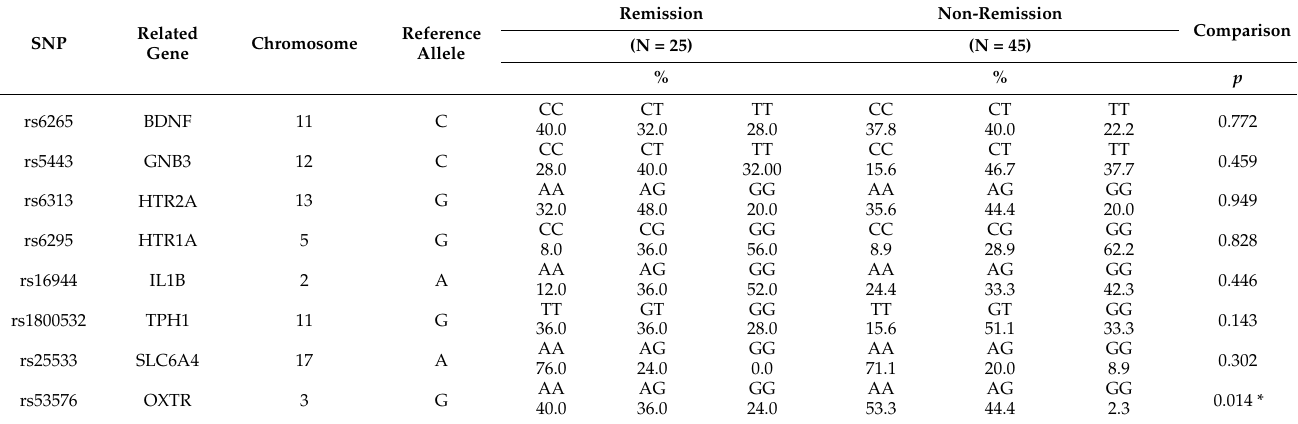
Table 4. Genotype of the remission and nonremission patients.